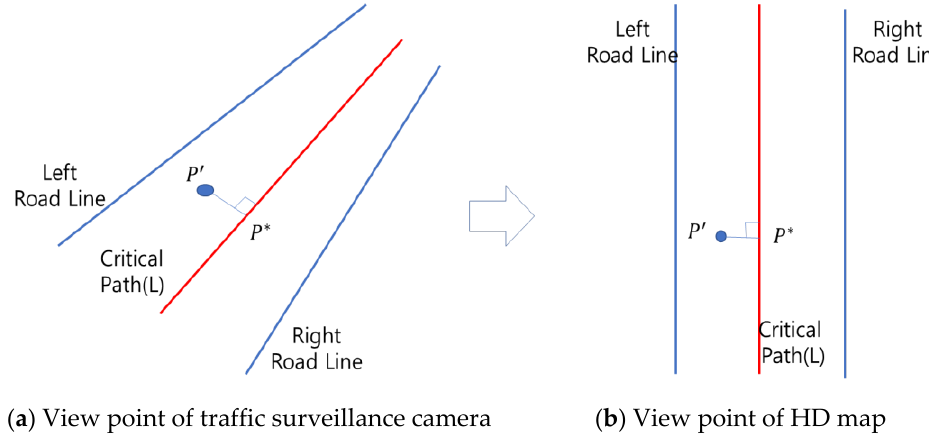
Figure 9. Definition of error estimation for the world coordinate.